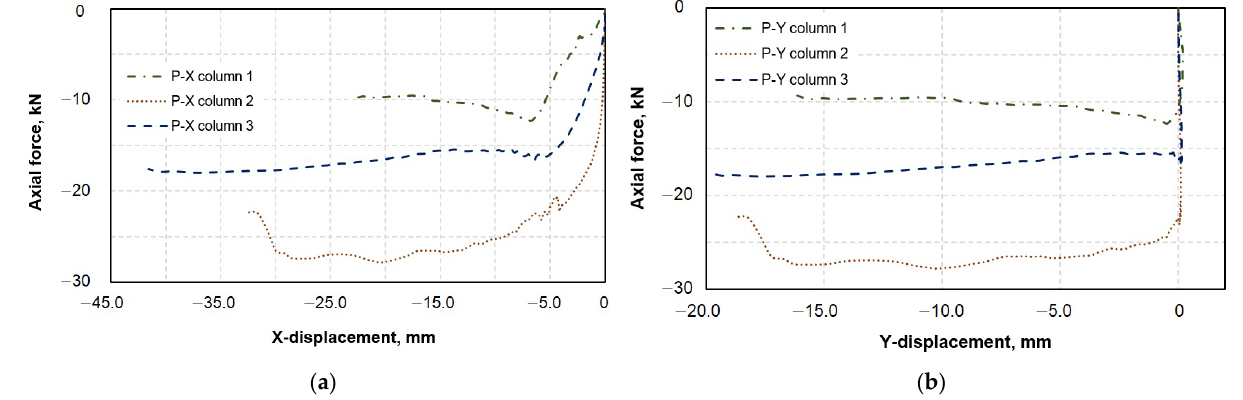
Figure 20. Force–displacement curves for the top edges of the columns: axial force–X displacement curve ( a ) and axial force–Y displacement curve ( b ).